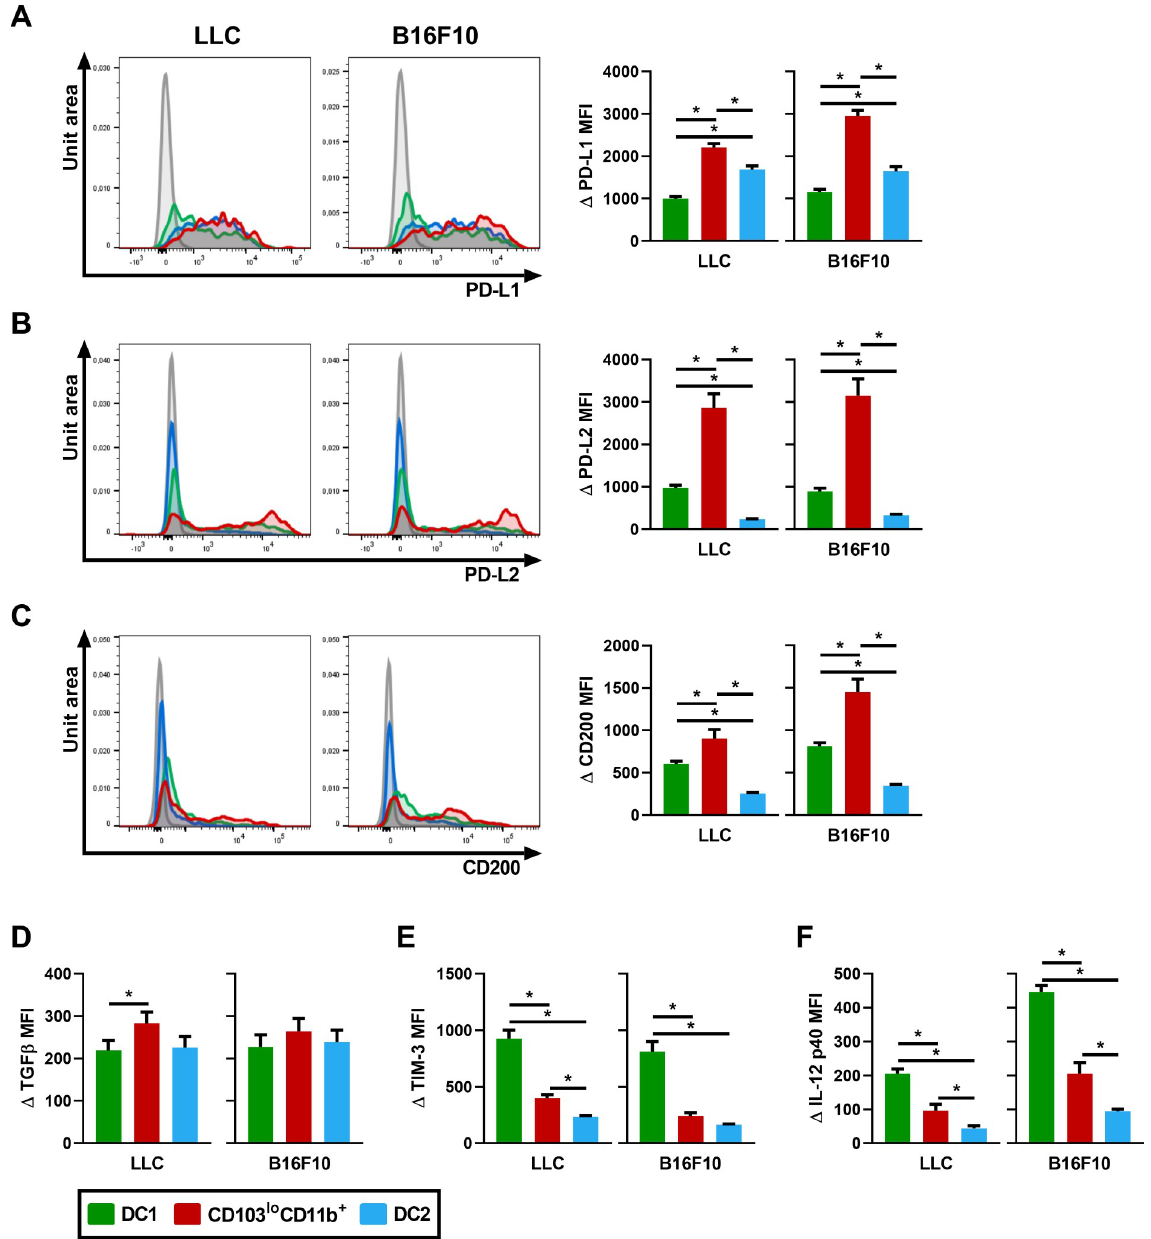
Fig 6. CD103 lo CD11b + DCs express regulatory molecules. Surface marker expression and cytokines production were analyzed by flow cytometry and compared between lung DC subpopulations following the i.v. injection of LLC or B16F10. Left panels on (A-B-C): representative flow cytometry histograms showing the normalized numbers of cells (unit area) on the Y-axis and fluorescence intensity on the X-axis for (A) PD-L1, (B) PD-L2 and (C) CD200. FMO control appears in grey in each histogram. Right panels on (A-B-C) and (D-E-F): comparison of (A) Δ PD-L1, (B) Δ PD-L2, (C) Δ CD200, (D) Δ TGF β , (E) Δ TIM-3 and (F) Δ IL-12 p40 MFI MFI between DC1 (green), CD103 lo CD11b + DC (red) and DC2 (blue) populations. Data are expressed as mean ± SEM. n = 10–17 pooled from two independent experiments. � = p < 0.05 using repeated measures one-way ANOVA, with the Geisser-Greenhouse correction followed by Tukey’s multiple comparisons test. differentiation of CD103 + XCR1 + DC1s in the presence of cancer cells (S2A Fig). Critically, the anticancer cytokine IL-12 was strongly induced when DCs were stimulated with live cancer cells (not with the antigenic preparation) two days after GM-CSF stimulation (Fig 7A). This